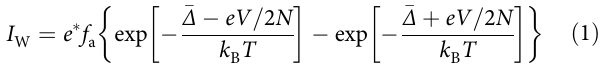
Fig. 4c on a semilog scale. The data at ν = 0.16 display exponential increase in the current I between V = 0.1 – 1.8